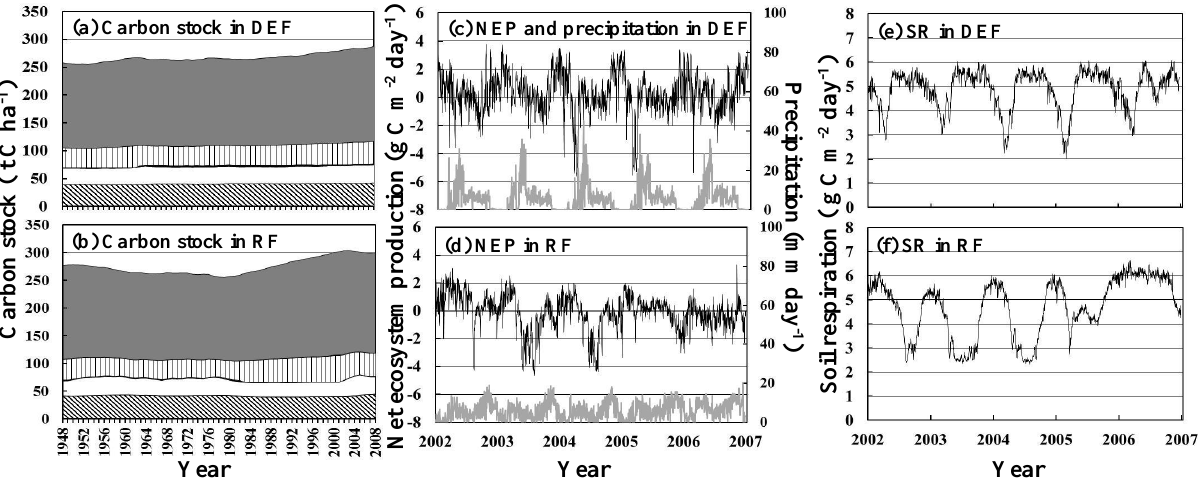
Fig. 5. Temporal variations in (a, b) carbon stock, (c, d) net ecosystem production (NEP: black line) and daily precipitation (gray line) and (e, f) soil respiration (SR) in dry evergreen forest (DEF) in Thailand (top) and the rainforest (RF) in Malaysia (bottom) simulated by the VISIT model. The subclasses of C stock are aboveground biomass of canopy tree (gray), belowground biomass (vertical), understory plant biomass (black), dead biomass and detritus (litter; white) and humus (diagonal line) from top to bottom. Fig 6